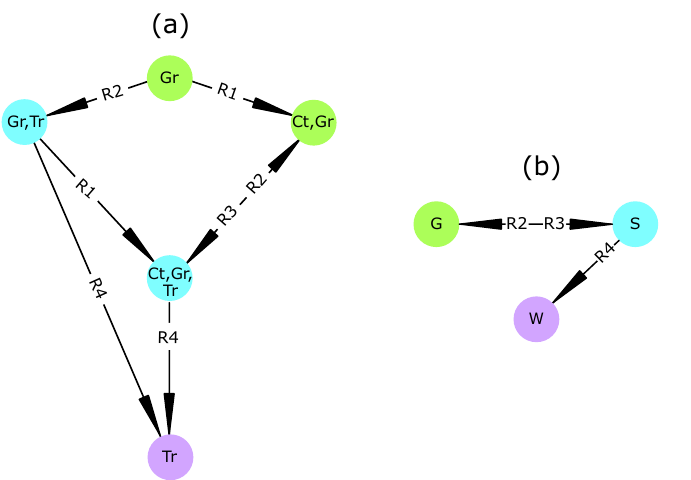
Figure 1. Transition graphs of the “Grasses-Trees-Livestock” toy model (Table 1). ( a ) State-Transition Graph (STG) depicting every reachable states and transitions from the initial state, with node labels corresponding to active variables Gr (Grasses), Tr (Trees), and Ct (Cattle). ( b ) Vegetation summary graph depicting transitions between vegetation types. This graph was made from ( a ) by merging nodes of the same color. In both graphs, node colors correspond to vegetation types, with green for grassland (G; defined as Gr+, Tr- ), blue for savanna (S; Gr+, Tr+ ), and purple for woodland (W; Gr-, Tr+ ). Note that some rules may be defined and never be executed (e.g.,